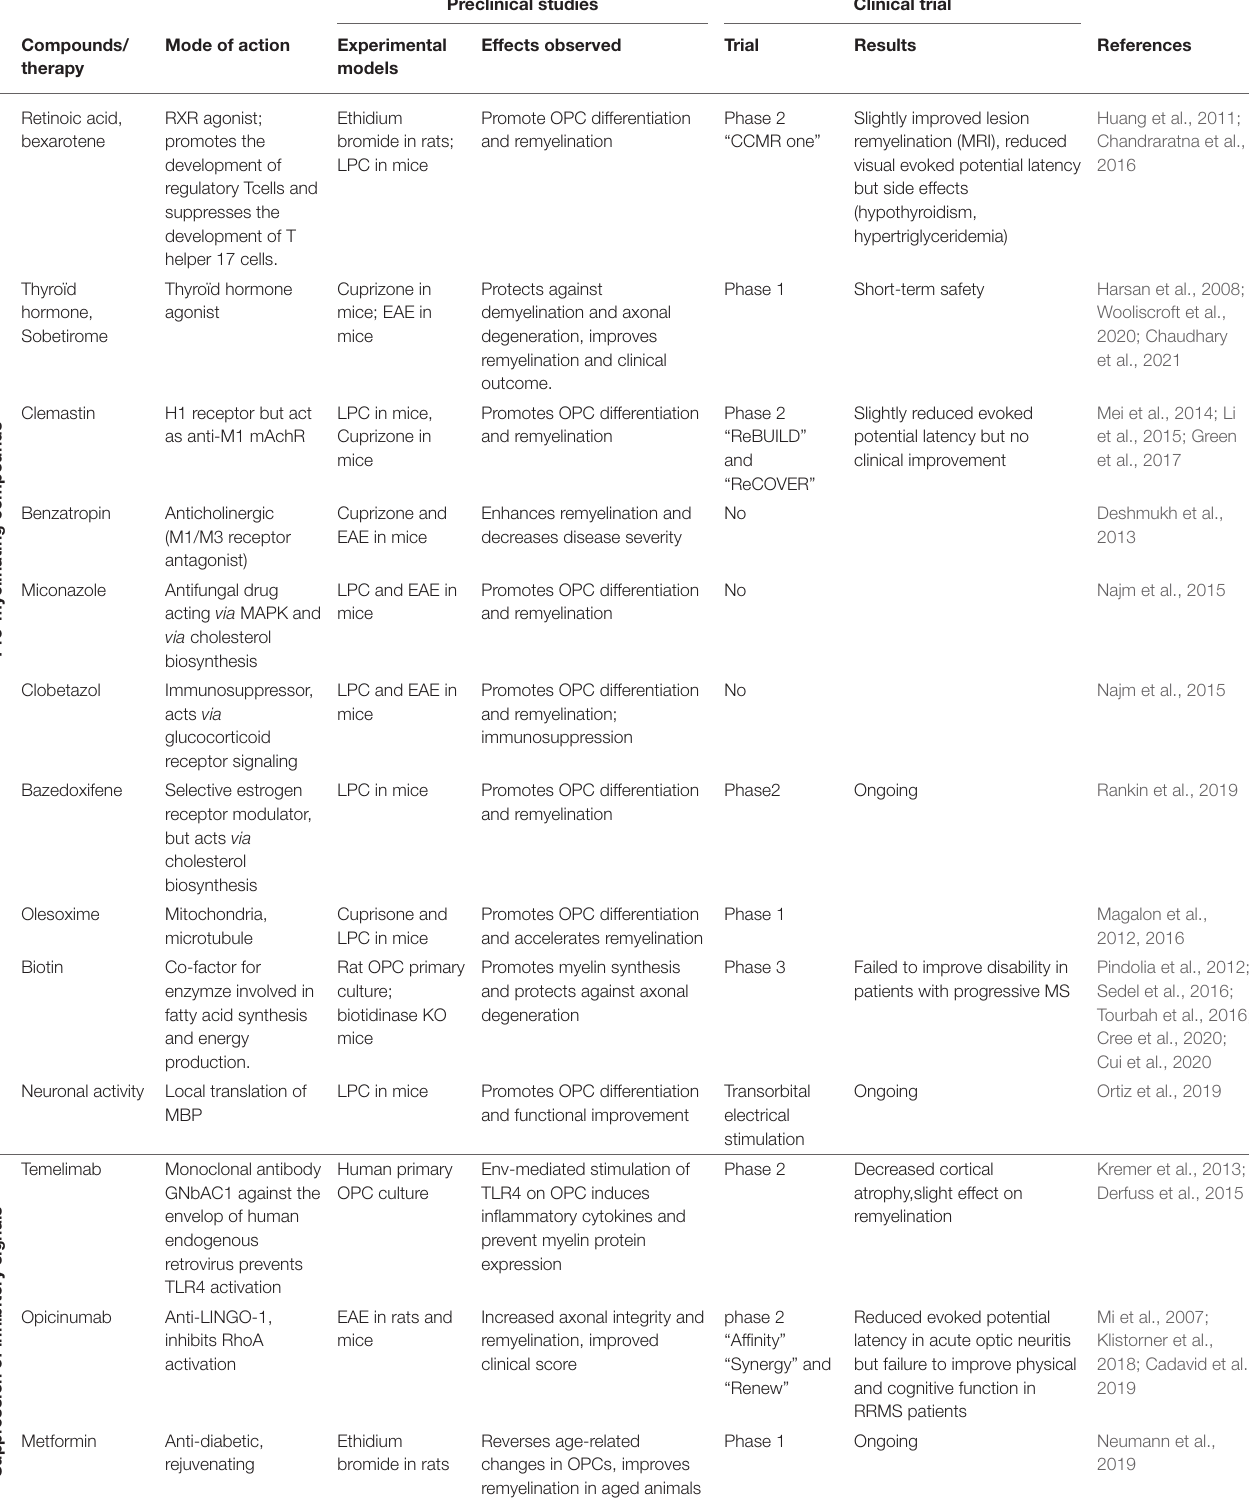
TABLE 1 | Compounds and therapies promoting